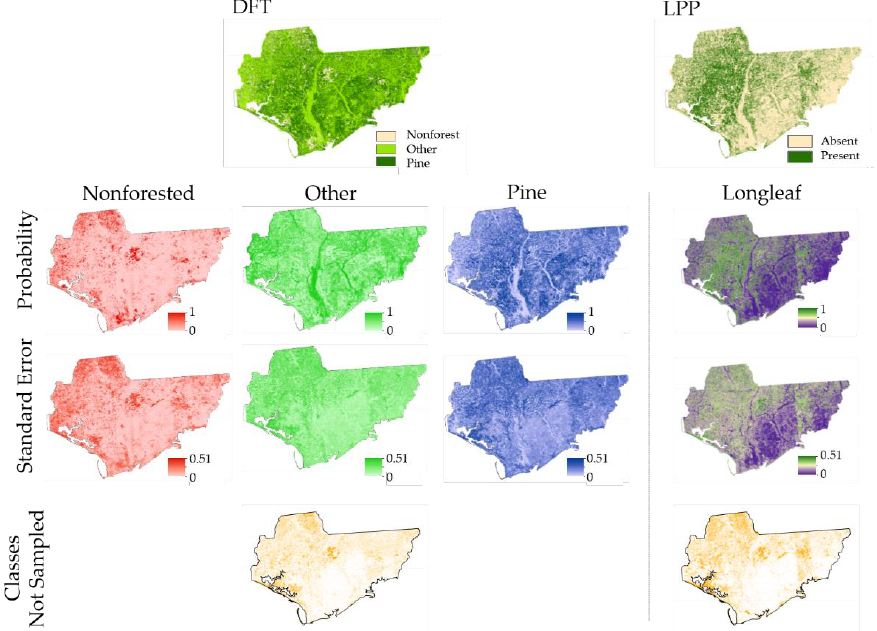
Figure 10. Spatial distribution of the dominant forest type most likely class (DFT), class probabilities, and class probability standard errors for Nonforested (red), Other (green), and Pine (blue) cover types (Table 1). Additionally, presence and absence of longleaf pine within a plot based on a most likely class rule (LPP), presence probabilities, and presence probability standard errors (purple to green color gradient). Finally, the spatial location of k-mean classes not represented in the sample used to train EGAMs are displayed as orange areas in the bottom row of graphics.